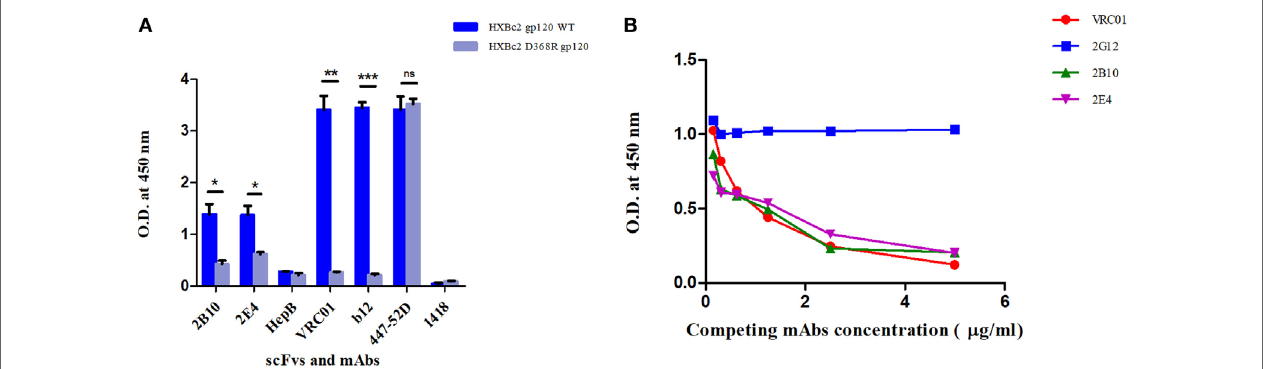
FigUre 3 | ELISAs to determine epitope specificities of scFv monoclonals. (a) Purified scFv monoclonals were checked for binding reactivity with HXB2 gp120 WT and its D368R mutant by ELISA. Here, anti-HIV-1 bnAbs VRC01 and b12 were used as positive controls and anti-V3 mAb 447-52D, anti-Parvovirus mAb 1418 with anti-hepatitis scFv HepB were used as negative controls. Mean binding titers were compared using unpaired t -test. P values < 0.05 were considered significant and shown by asterisk (*) symbol, (**) if p < 0.01 and ( *** ) if p < 0.001. Here, ns is designated for “not significant.” (B) Competition ELISA of biotinylated VRC01 (at fixed concentration of 50 ng/ml) to BG505:SOSIP.664 D-7324 with decreasing concentrations of scFvs (2B10 and 2E4) and mAbs (2G12, VRC01). 2G12 bnAb was used as negative control, and the bnAb VRC01 was used as positive control for the assay. Dilution used for antibodies was 5 µg/ml to 0.1526 µg/ml.